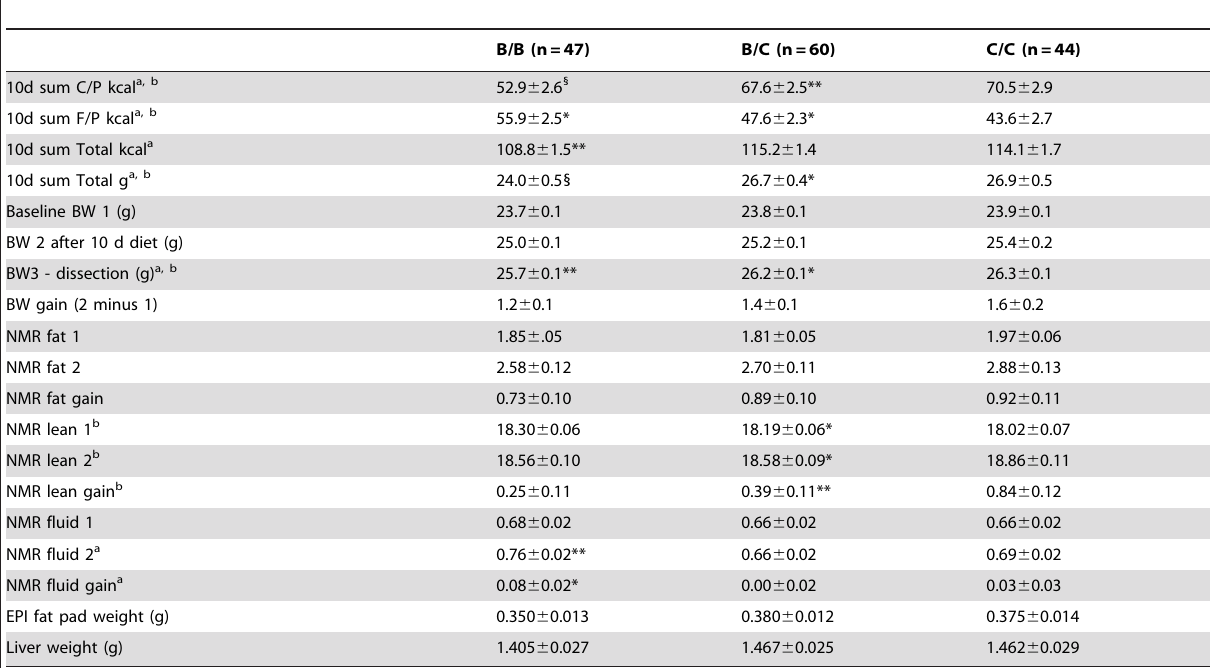
Table 1. Phenotypic data for food intake, body weight, body composition and organ weights in non-recombinant B6.CAST-17.1- derived F 2